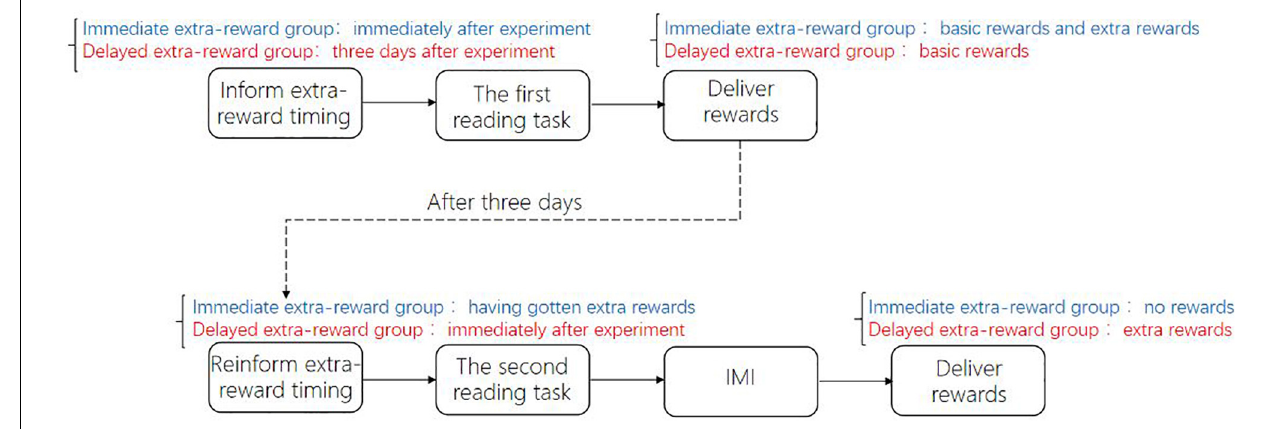
FIGURE 3 | Experimental procedure of Study